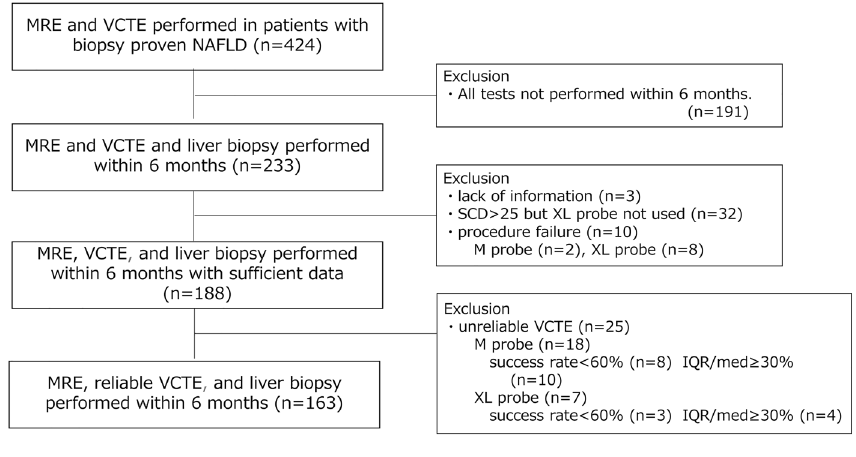
Figure 2. Flow chart of patient